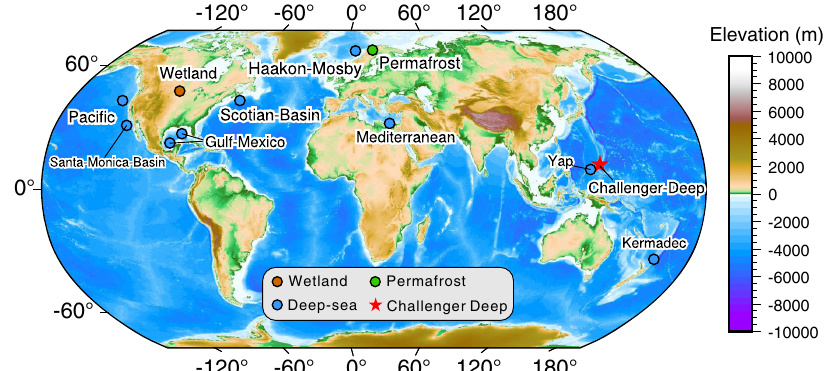
Fig. 1 Global map indicating the Challenger Deep (this study; shown with a red star), the hadal and non-hadal deep-sea settings (blue), wetland (brown), and thawed permafrost (green) sites used for metagenomic comparisons in this study. The map was generated by Yingli Zhou using the Generic Mapping Tools (v.6.0) 121 and SRTM15 + (V2.0) data